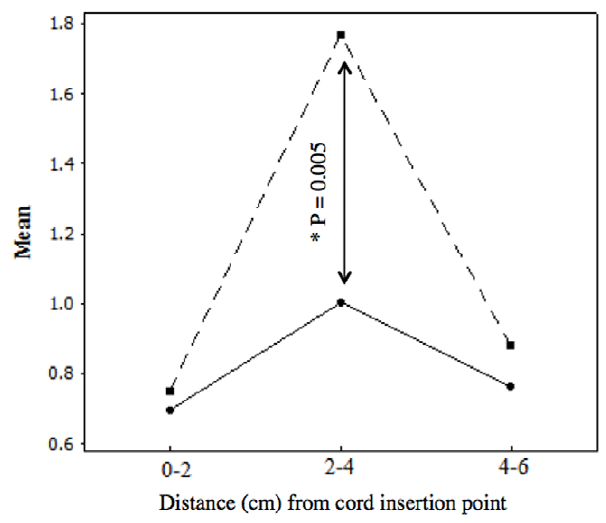
Figure 5. Shows an interaction plot for HSP 70 showing the relationship between the means of the 3 different areas of the placenta sampled (0–2, 2–4 and 4–6 cm) and the two patient groups. Non-labor solid line(n=6 patients); labor broken line (n=6